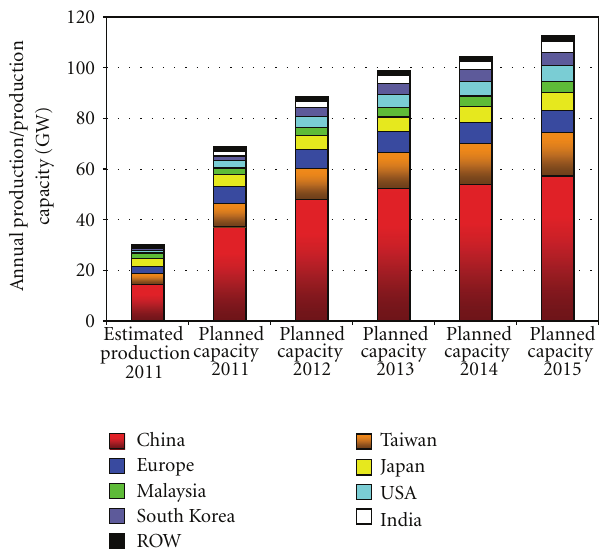
Figure 4: Actual and planned PV production